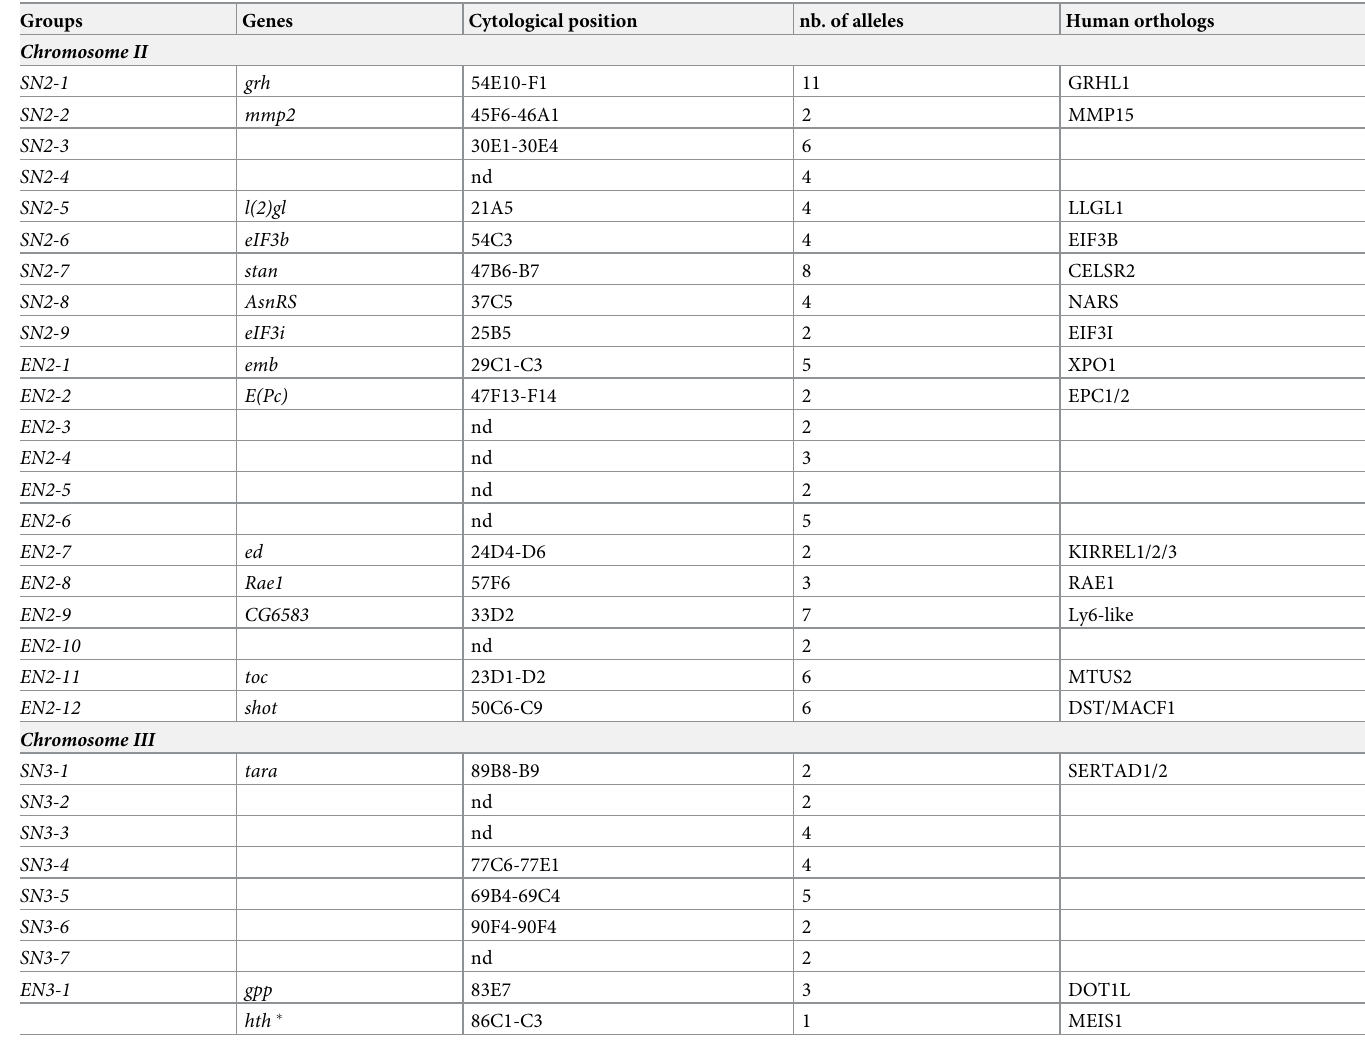
Table 1. Groups of dominant modifiers of NA9 on second and third